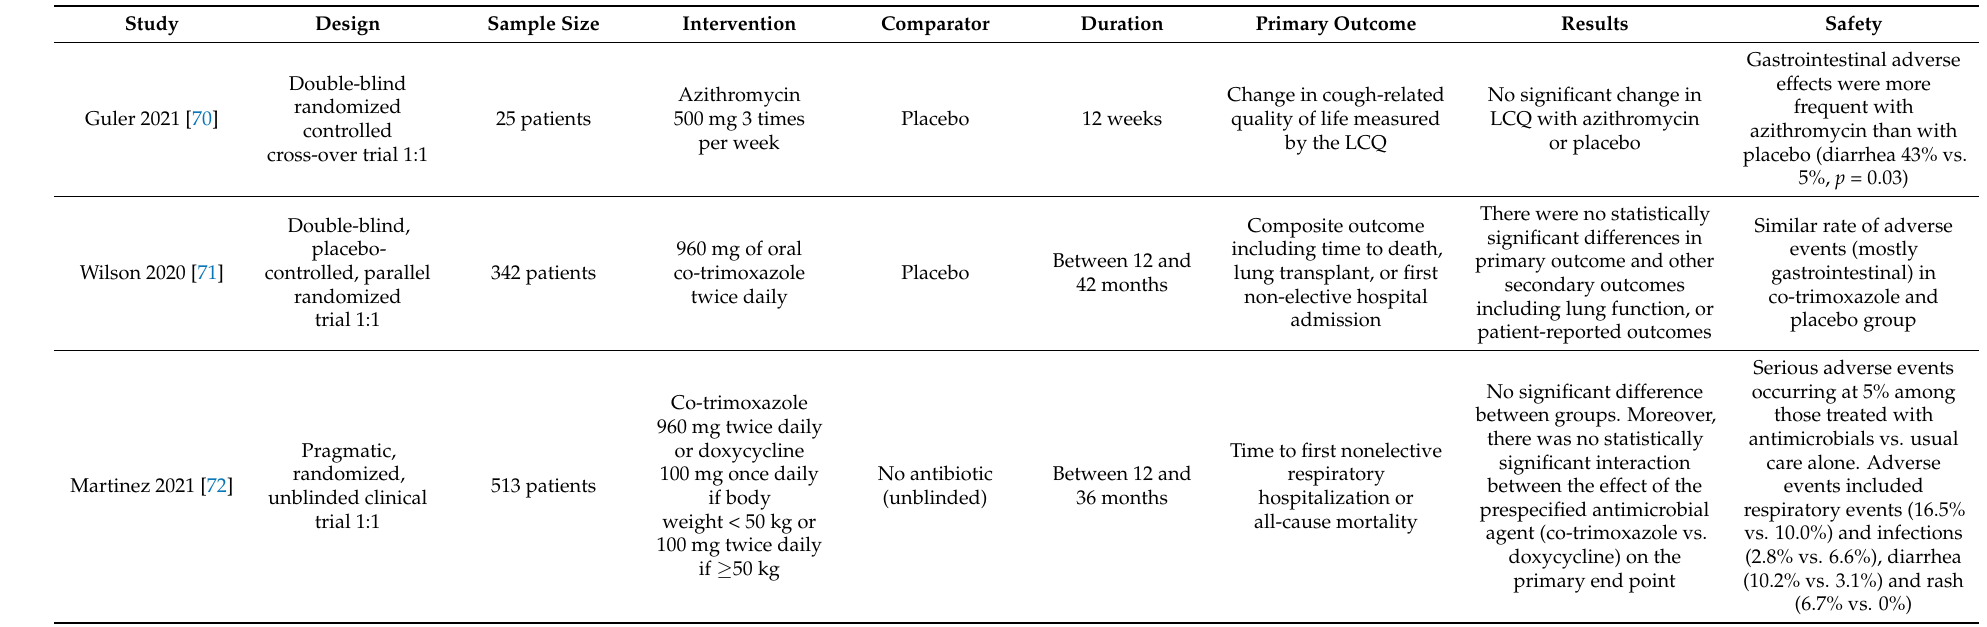
Table 3. RCTs evaluating antimicrobial in idiopathic pulmonary